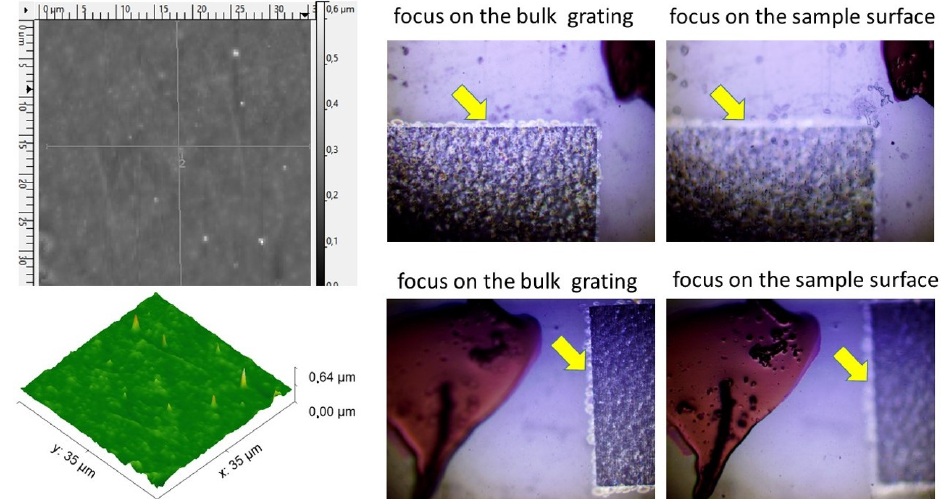
Figure 3. ( left side) AFM relief maps of the PET sample surface with the micrograting inscribed in its bulk (depth ≈ 50 µm). ( right ) Optical images of the PET sample with the focus on the micrograting (shown by the yellow arrow) and sample surface.